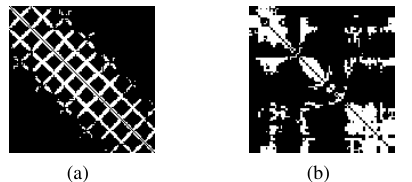
Figure 4: Rows and columns of the epipolar graph represent in- dividual cameras and their connections to each other based on shared feature matches and image overlap. (a) shows a traditional aerial survey with regular flight pattern, (b) the connections be- tween cameras for an unordered oblique image data set. rupted by outliers and gross errors, the verification of the relative tion method within a RANSAC loop (Fischler and Bolles,